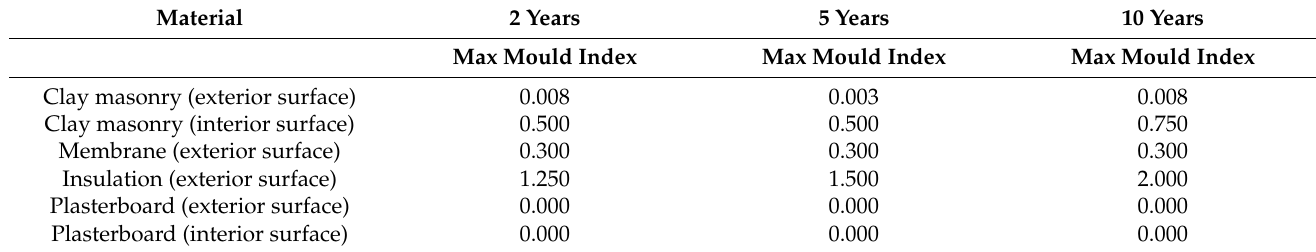
Table 14. Mould growth simulation results for the 7-star clay masonry veneer wall—western